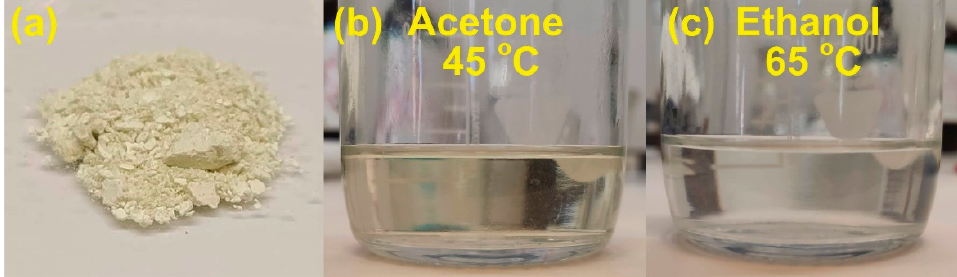
Figure 3. ( a ) Extracted pine wax powder and obtained solutions in ( b ) acetone and ( c )